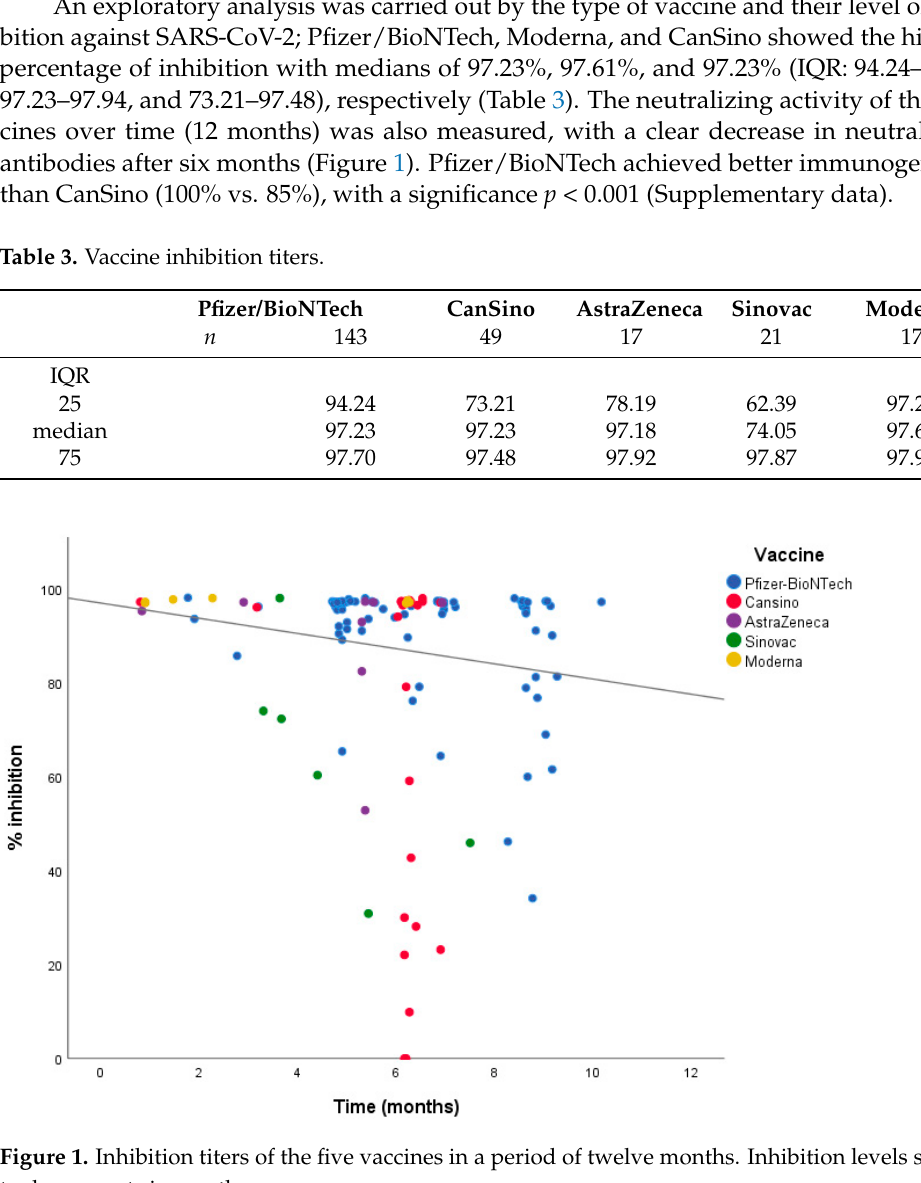
Figure 1. Inhibition titers of the five vaccines in a period of twelve months. Inhibition levels started to decrease at six